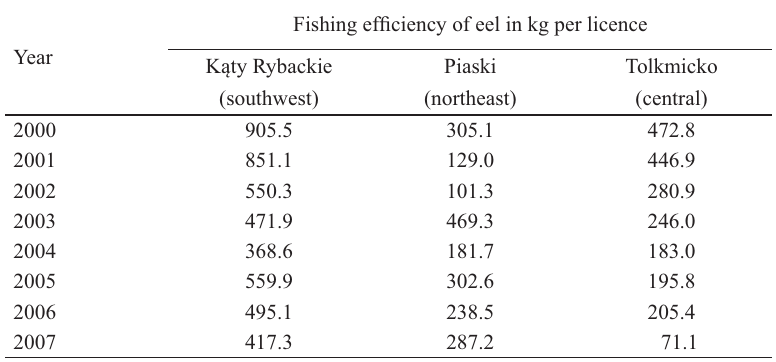
Fishing efficiency of eel from official statistics at three fishery bases at different geographic